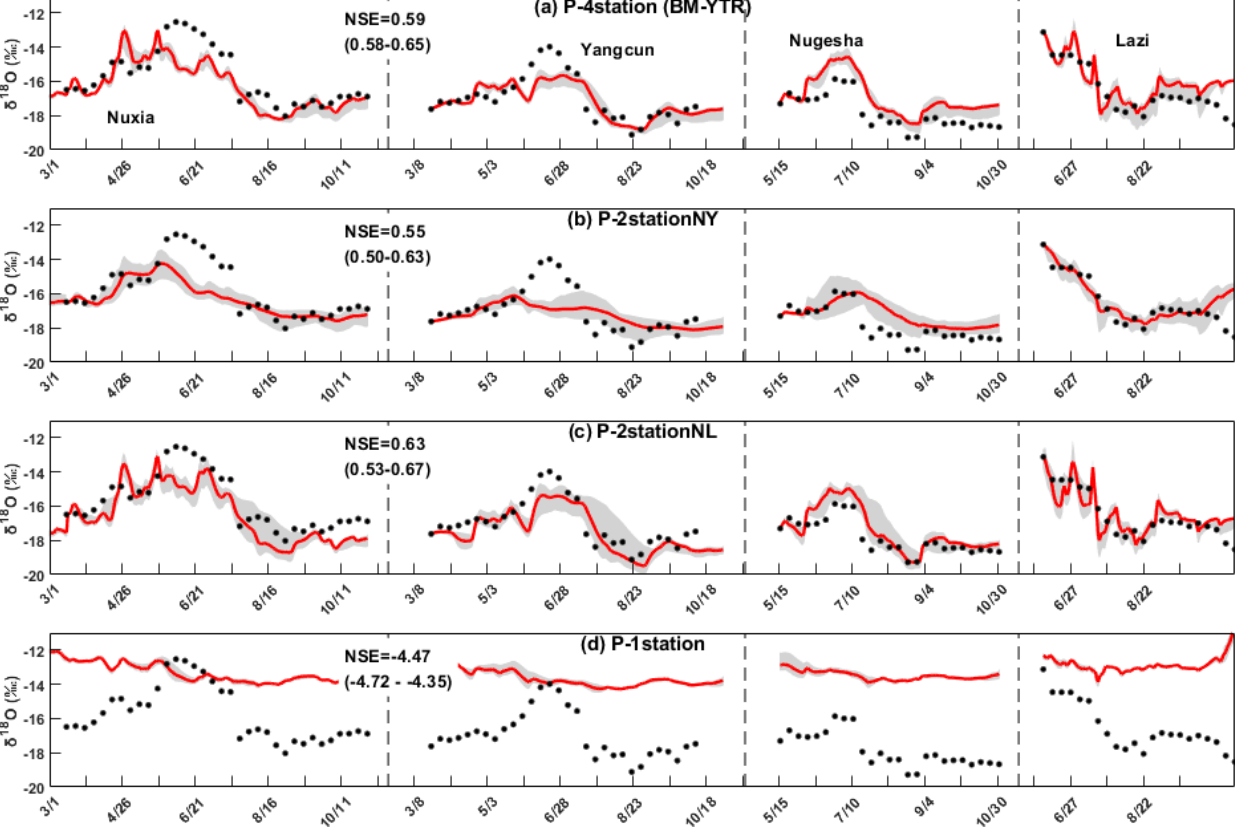
Figure 7. Uncertainty ranges of stream water δ 18 O simulations at four stations in 2005 produced by the behavioral parameter sets of each scenario in Experiment